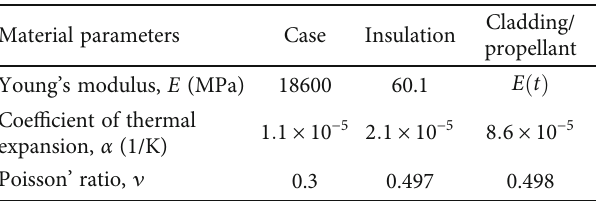
Figure 2: Finite element mesh of the solid rocket motor. Table 1: Basic material parameters.